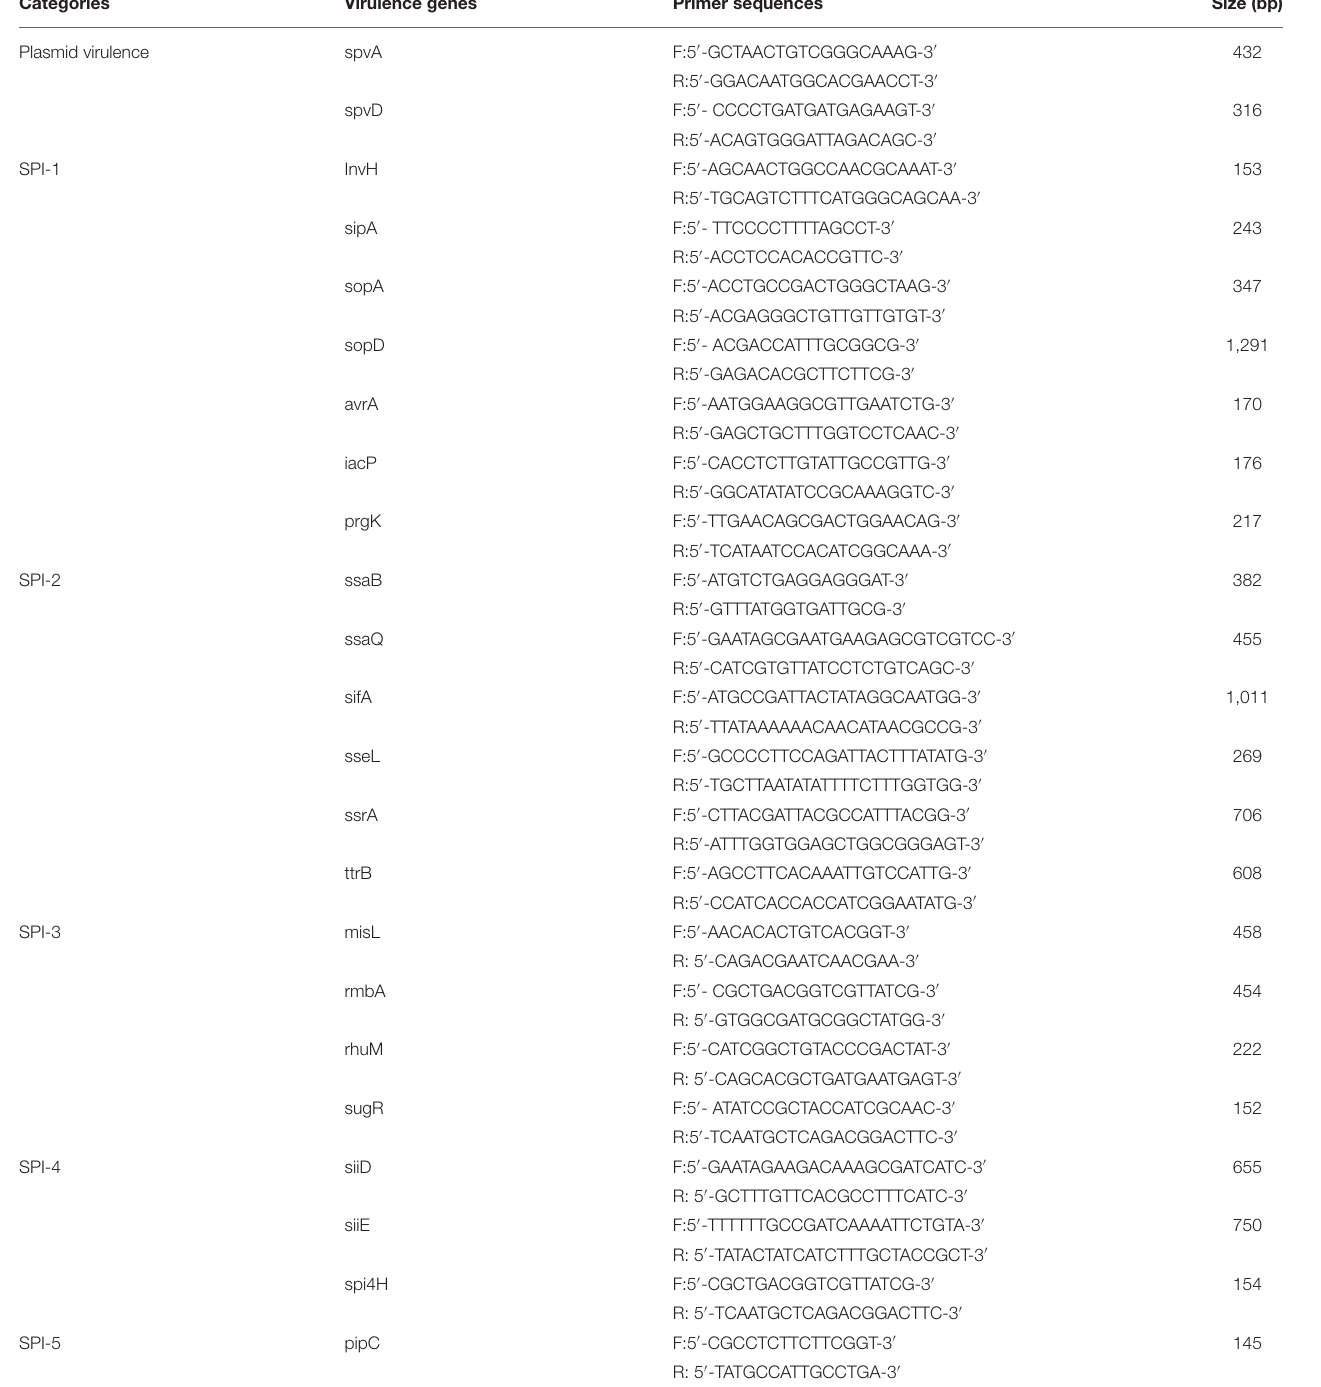
TABLE 3 | Primers sequences for PCR of virulence